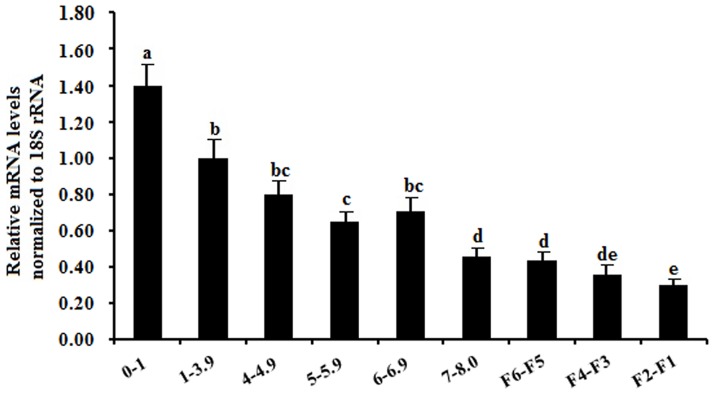
Quantification of expression levels of the SAV1 mRNA in variously sized follicles from freshly collected ovaries.The data are the mean ± SEM from 10 hens (n = 10), and bars with different letters above them differ significantly in the amount of mRNA expression as normalized to the 18S rRNA gene (P < 0.05). Horizontal ordinate represents the examined follicle sizes as indicated: 0-1mm, small follicles (<1 mm in diameter); 1–3.9 mm, the prehierarchical follicles were from 1 to 3.9 mm in diameter; 4–4.9 mm, from 4 to 4.9 mm in diameter; and the others followed similarly.